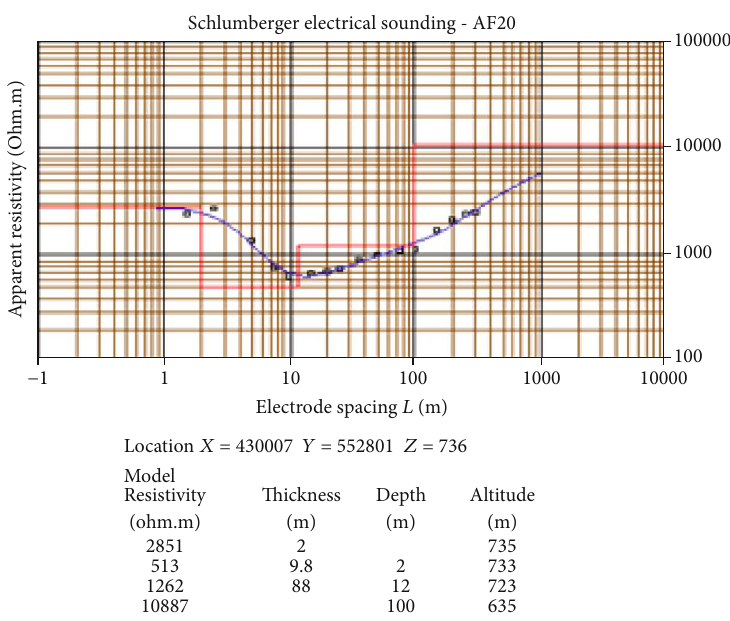
Figure 12: Sounding curve (AF